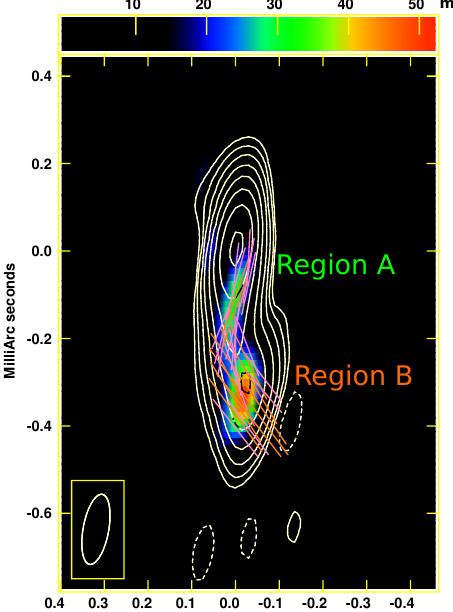
Figure 3. High-resolution intensity and polarization image of BL Lac at 86 GHz (3 mm) obtained on May 17, 2013 (beam FWHM: 0.172 × 0.0748 mas at − 8.38 ◦ ). Contours represent total intensity and the peak flux is 1.04 Jy/beam; contour levs are ( − 0.07%, 0.07%, 0.14%, 0.28%, 0.56%, 1.12%, 2.24%, 4.48%, 8.96%, 17.92%, 35.84%, 71.68%) of the peak flux. The polarized intensity is shown via the color scale. The solid ticks mark the EVPA